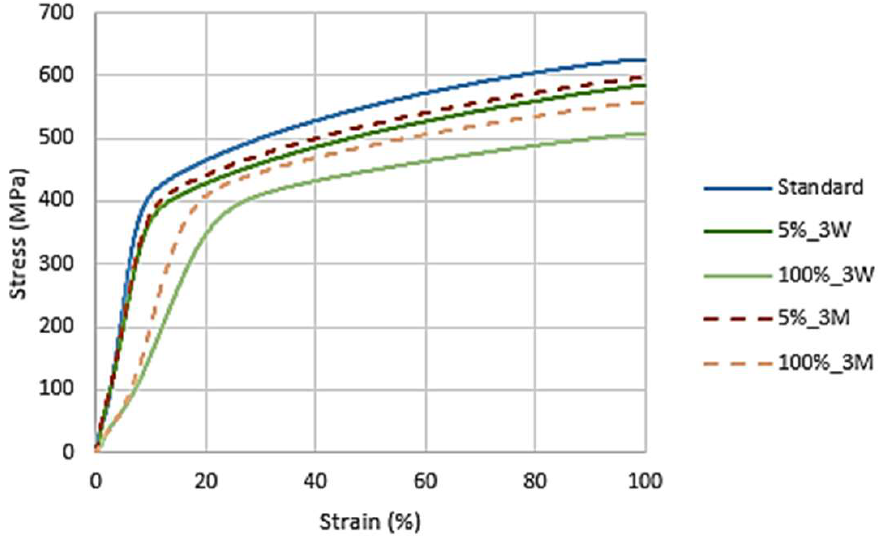
Figure 14. AISI 321 stress–strain curves after three weeks and three months of immersion.